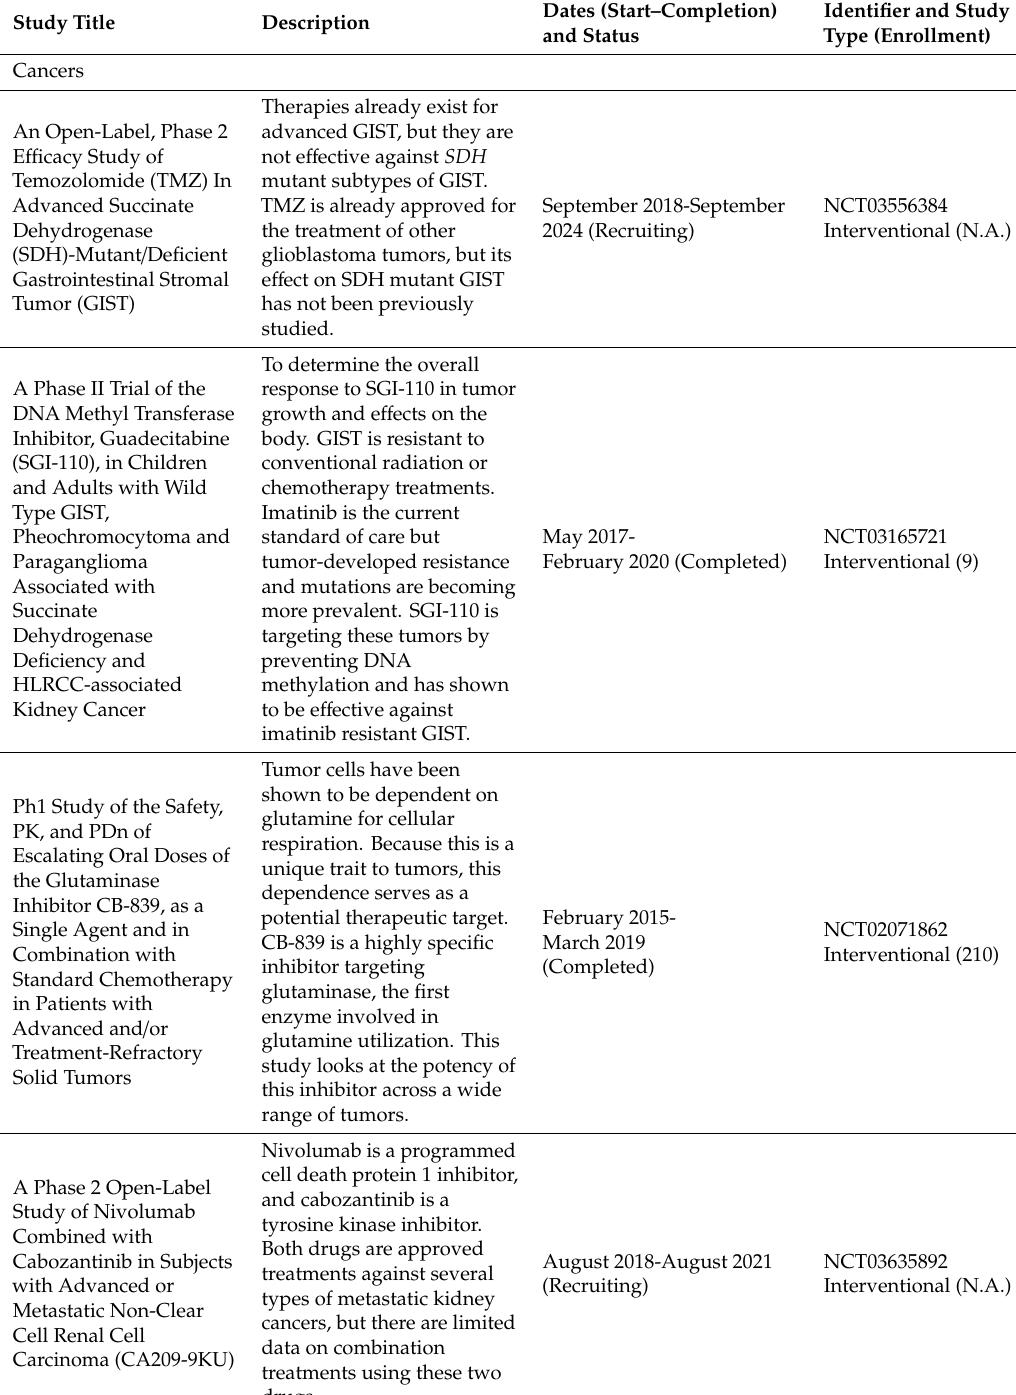
Table 1. SDH relevant clinical